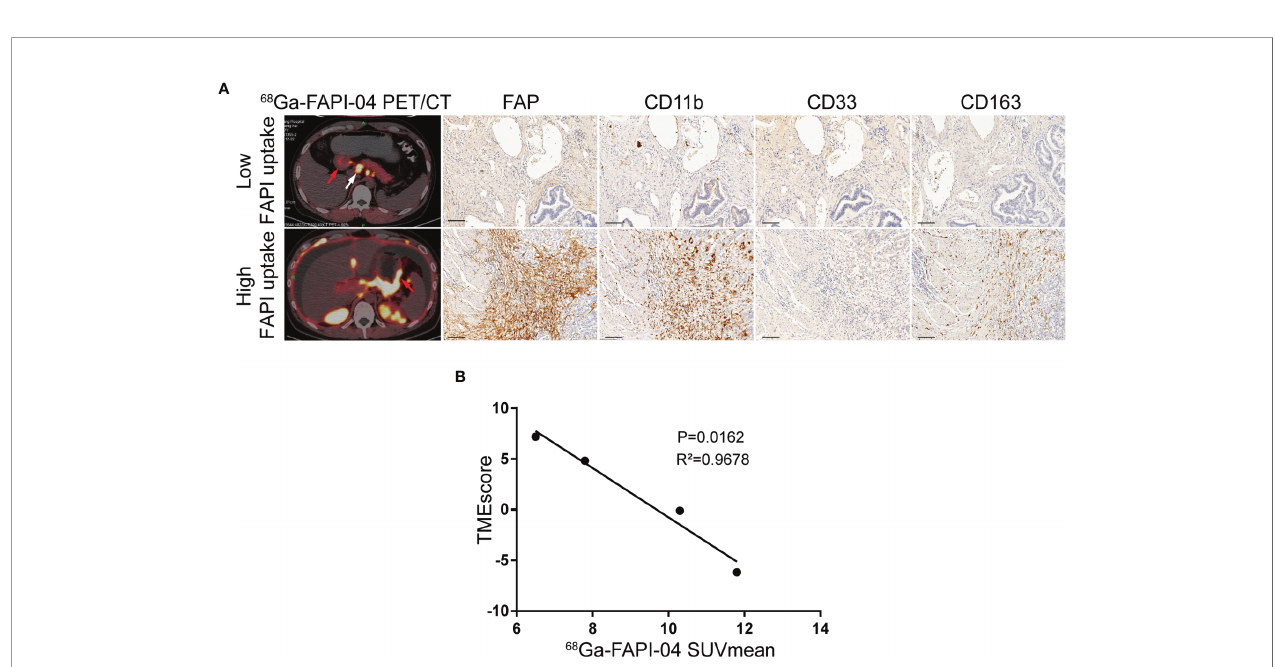
FIGURE 4 | FAPI imaging characterizes the immunosuppressive TME in GC. (A) Representative 68 Ga-FAPI-04 PET/CT images of patients with gastric cancer and IHC staining images for tumor specimens from gastroscopical biopsy of FAP, MDSC (CD11b+/CD33+), and macrophage M2 (CD163+) in fi ltration. Scale bar = 100 µm. The primary lesions are marked by red arrows, and the metastatic lesions are marked by white arrows. (B) Correlation analysis of TMEscore and the corresponding mean 68 Ga-FAPI-04 uptake ratios in primary gastric cancer or liver